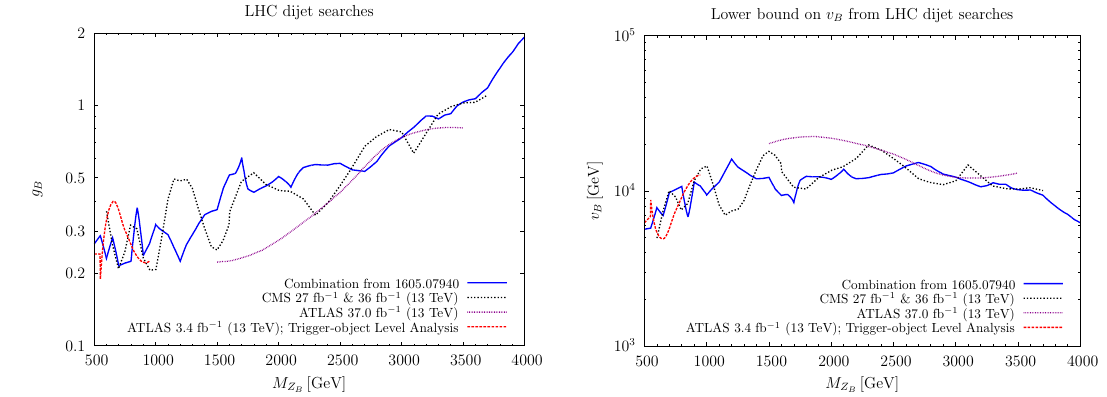
Figure 8 . Current experimental constraints on leptophobic gauge bosons from dijet searches [32{ 35]. Left panel: upper bound on g B as a function of M Z bounds in the mass-coupling plane as a lower bound on the symmetry breaking scale v B